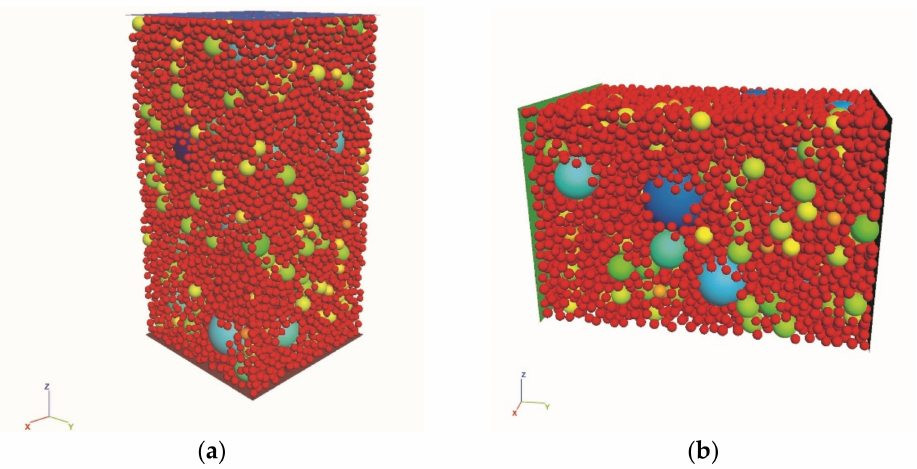
Figure 3. DEM models of the asphalt mixture for: ( a ) uniaxial compression; ( b ) direct tensile. The specimen of asphalt mixture is composed of aggregate, asphalt mastic and